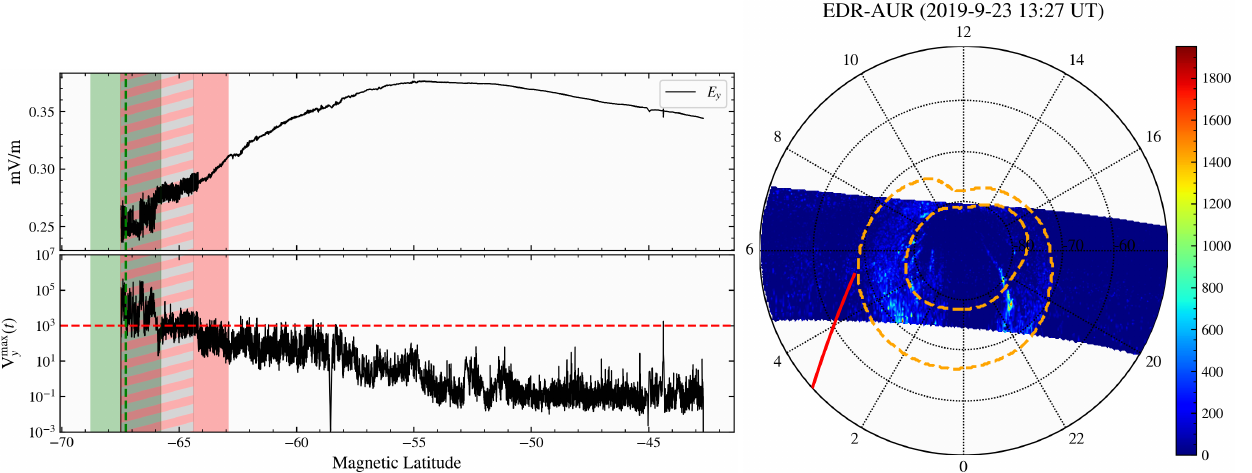
Figure 9. Same as Figure 7, except for orbit 9095. False Positive detection, nightside southern